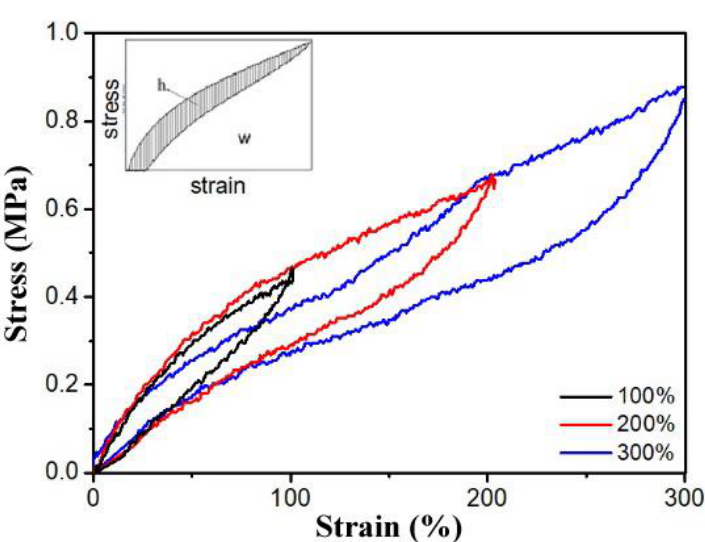
Figure 9. Cyclic stress-strain curves of PBS / MVQ composite rubber under 100%, 200% and 300% strain. The insert image is cyclic stress-strain curve.